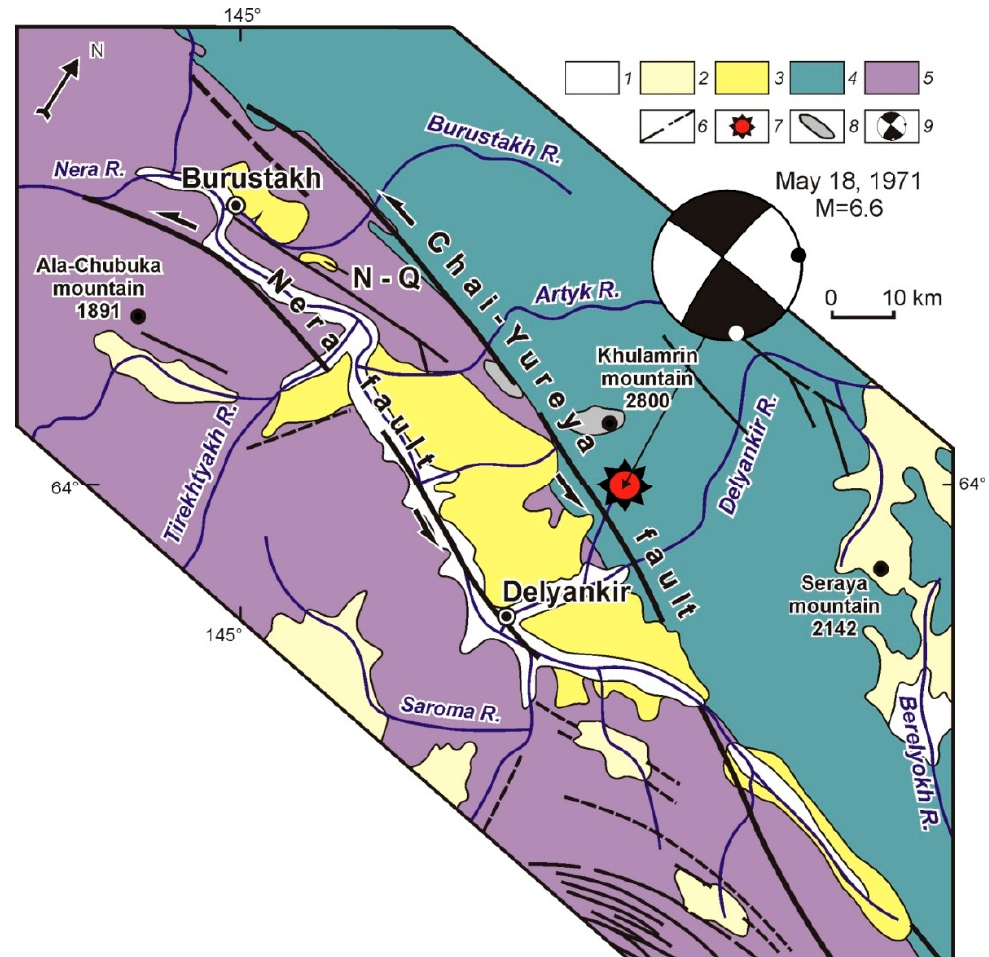
Figure 9. Geological model of the 1971 Artyk earthquake epicenter zone [29]. 1—modern alluvial deposits; 2—Middle Upper Quaternary water–glacial deposits; 3—Neogene–Quaternary deposits of the Verkhnener basins; 4—Jurassic sediments; 5—Triassic sediments; 6—lines of confirmed and inferred tectonic faults; 7—Artyk earthquake epicenter; 8—area of maximum values of ground surface deformation; 9—focal mechanism, dates and magnitudes of earthquakes (lower hemisphere; the principal stress axes of compression and extension are marked by black and white dots, respectively).